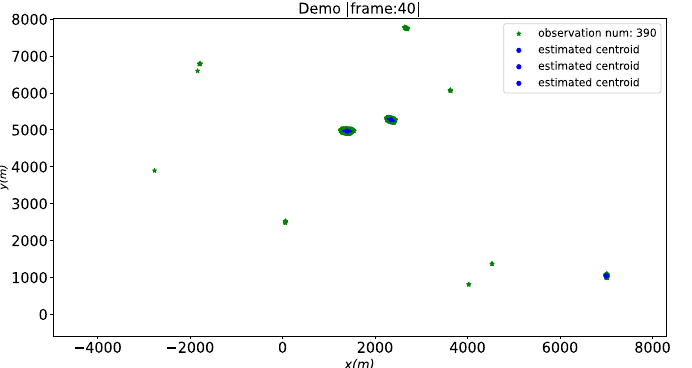
Figure 21. Multi-target tracking in the Cartesian coordinate system in the 40th frame.